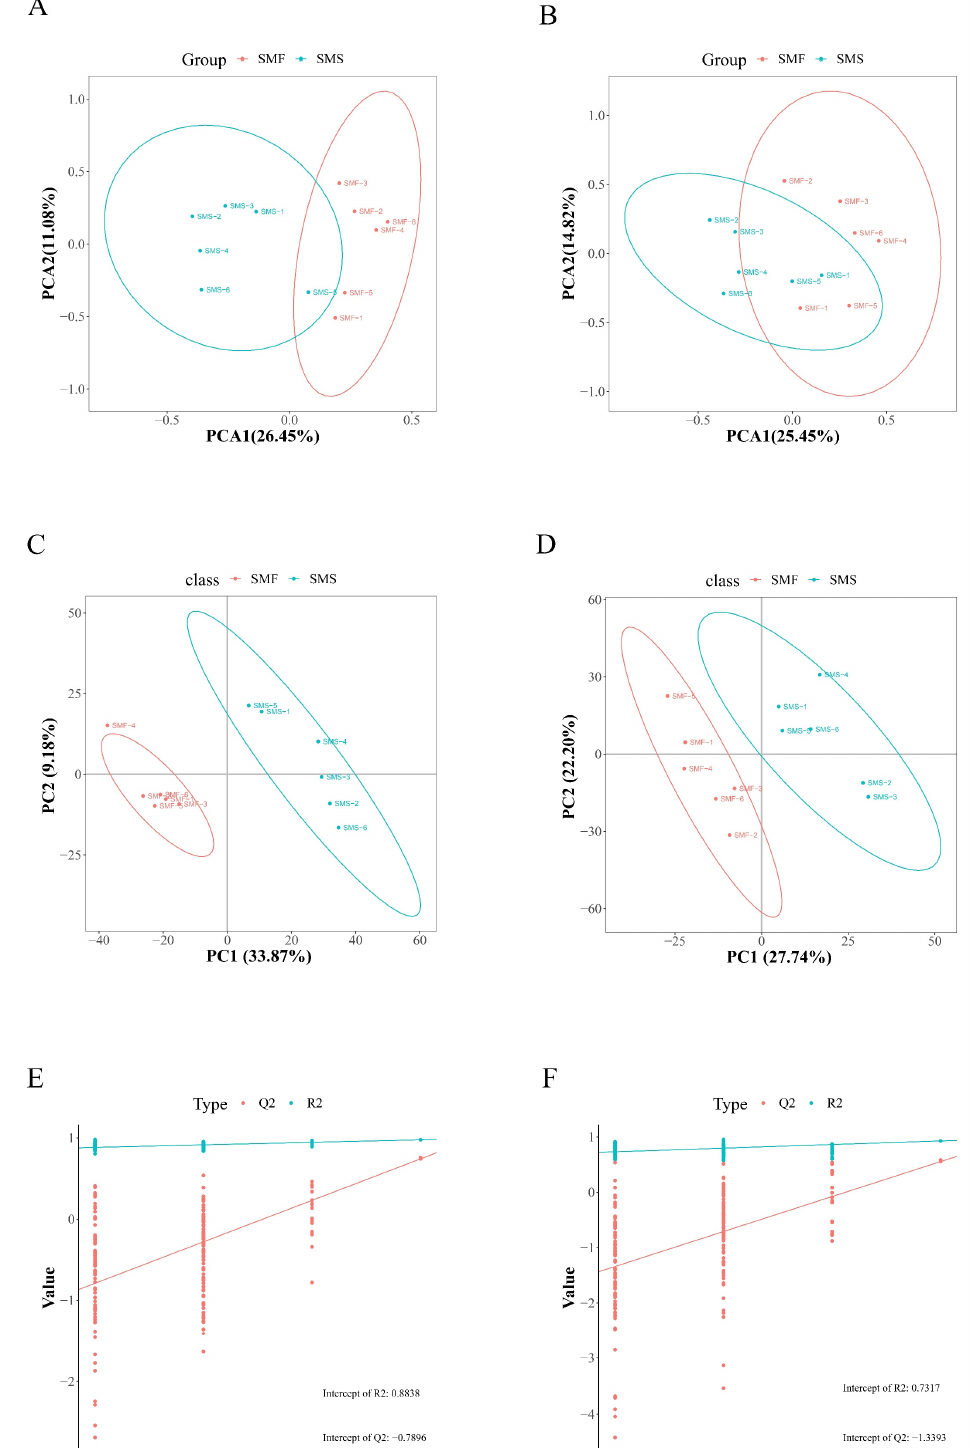
Figure 2. Quality analysis of metabolomics data. ( A ) The PCA scores plot of samples acquired in the positive ion mode. ( B ) The PCA scores plot of samples acquired in the negative ion mode. ( C ) The PLS-DA score plot for the positive ion mode. ( D ) The PLS-DA score plot for the negative ion mode. ( E ) The PLS-DA validation for the positive ion mode. ( F ) The PLS-DA validation for the negative ion